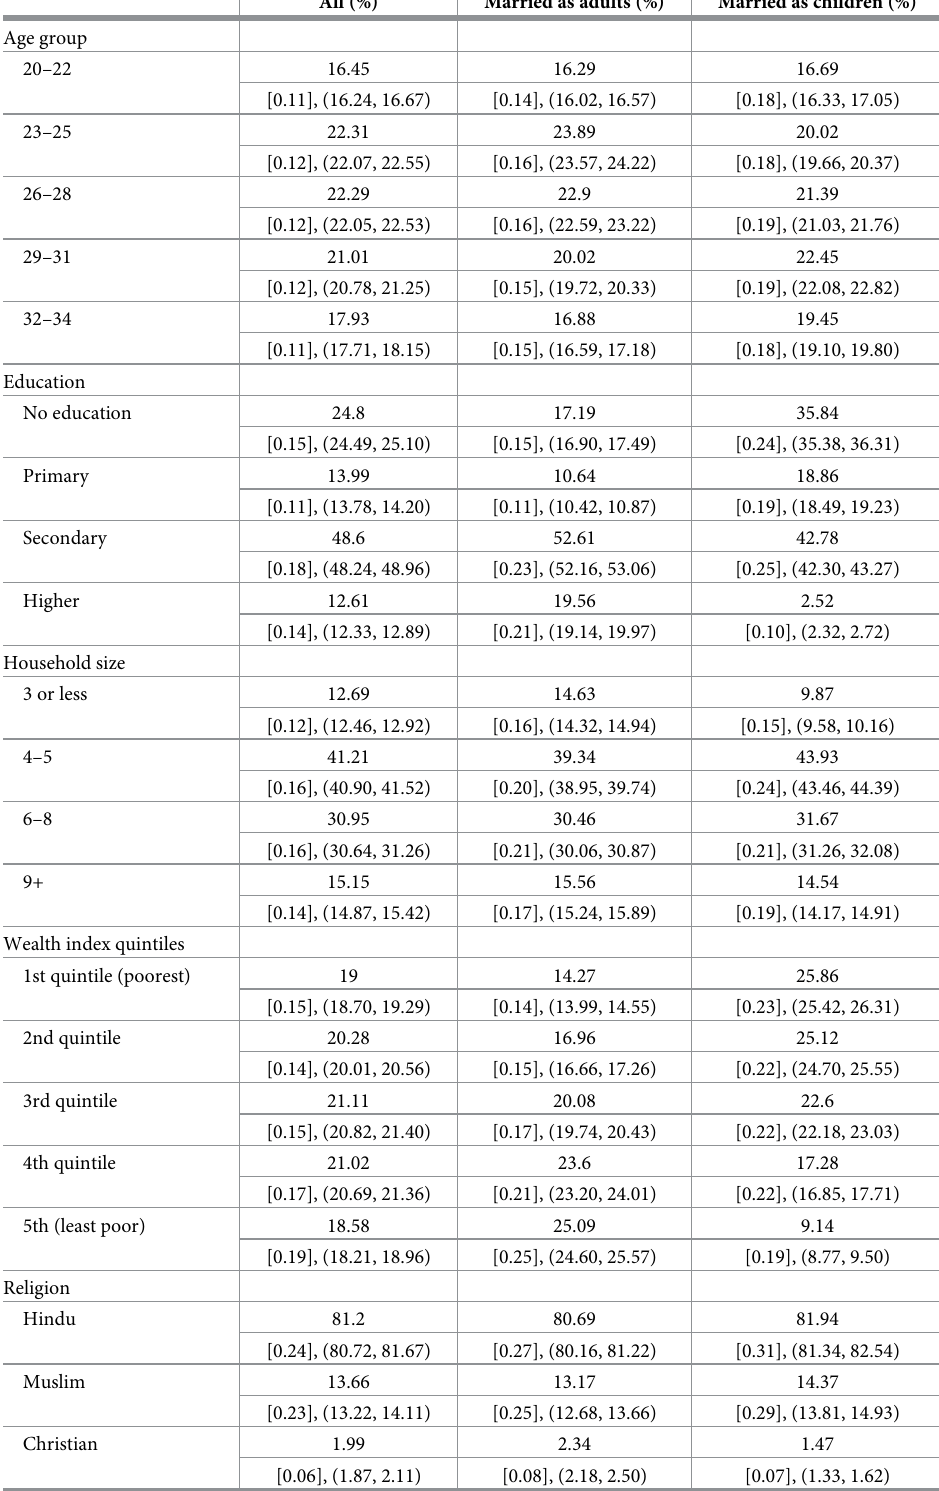
Table 1. Background characteristics of the study participants by child